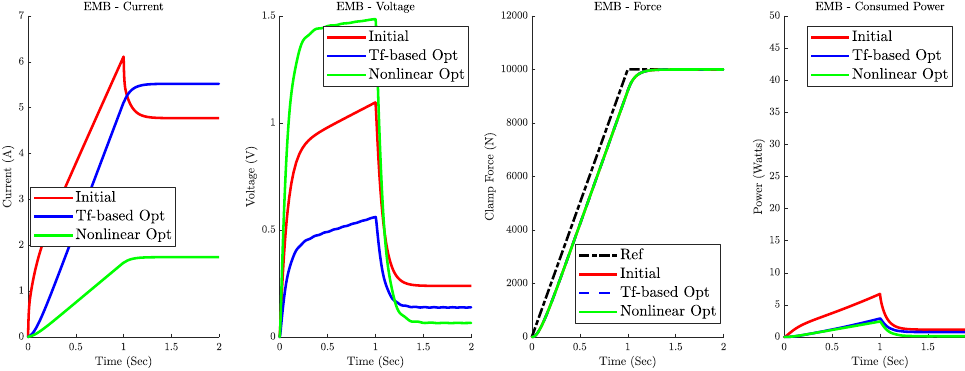
Figure 12. Comparison of the initial parameter sets vs. optimized in an EMB for a ramp input.